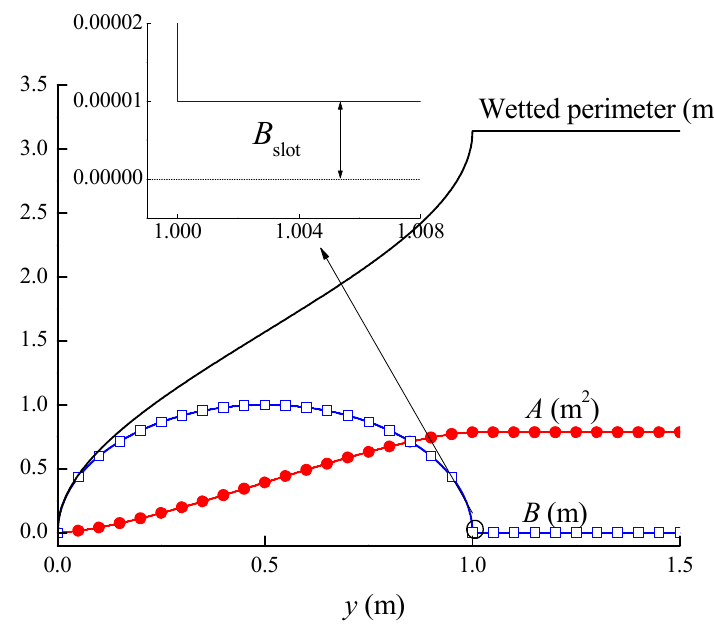
Figure 6. Parameters of a profile with a virtual slot.